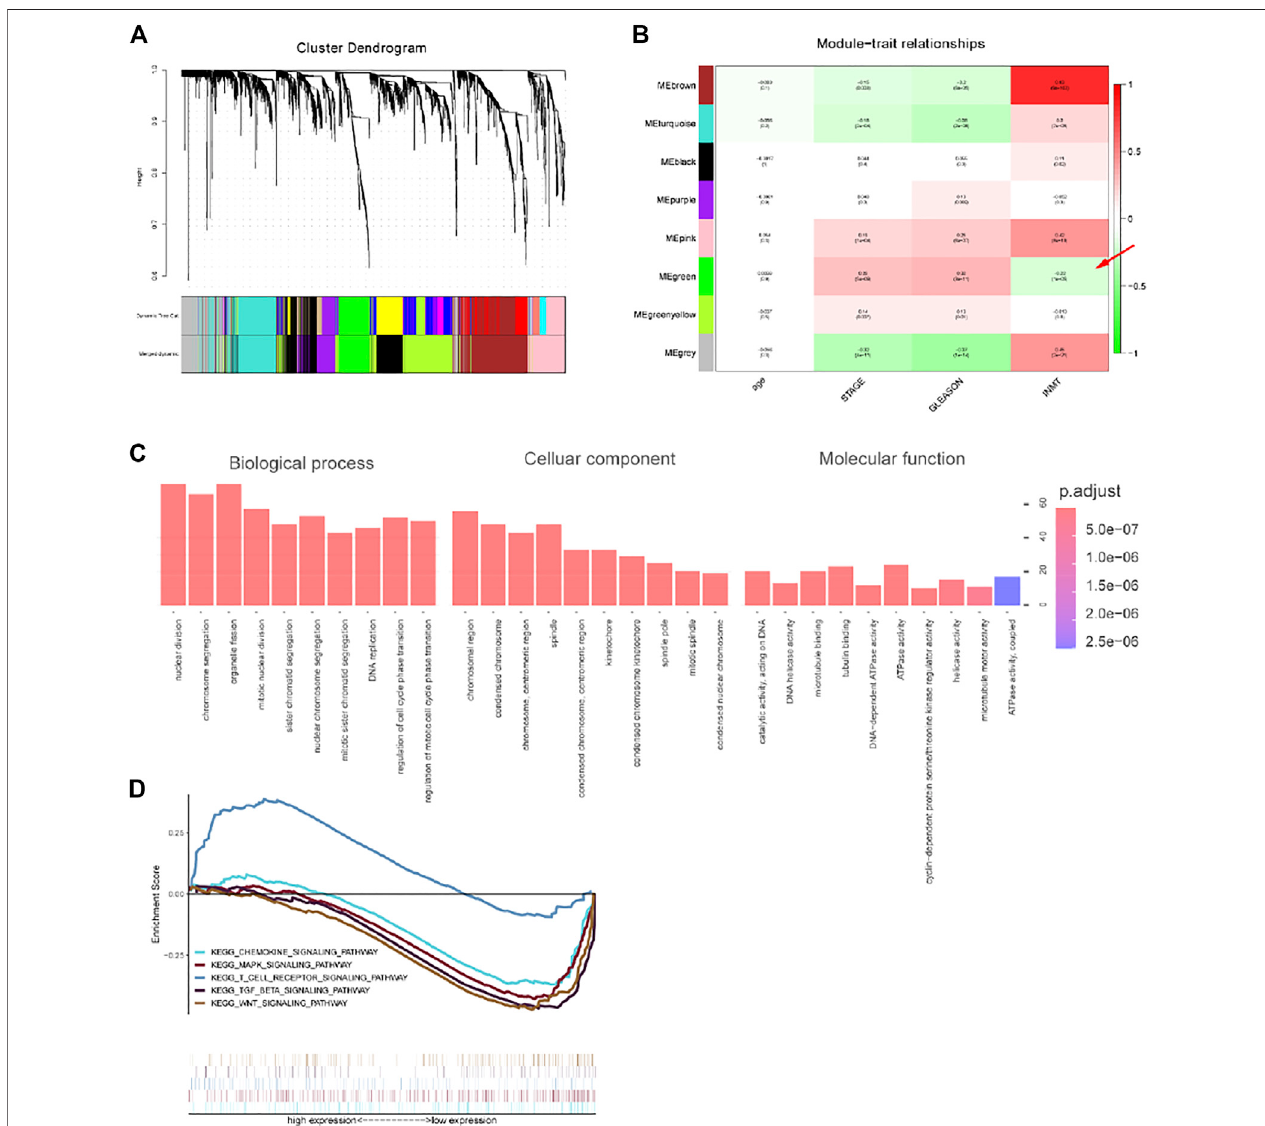
FIGURE3| Resultsofweightedgeneco-expressionnetworkanalysisinTCGA-PRAD. (A) Ahierarchicalclustertreewasconstructed,witheachleafrepresentinga gene and each branch representing a co-expression module. A total of eight co-expression modules were generated. (B) Correlation coef fi cients between different factors and co-expression modules, where the brown (COR = 0.83; p < 0.001), gray (COR = 0.45; p < 0.001),and pink modules (COR = 0.42; p < 0.001) had a positive correlation with INMT, and the green module (COR = -0.22; p < 0.001) had a negative correlation with INMT. (C) The pathway enrichment analysis of the INMT co- expression genes in the green module. (D) The KEGG pathway annotation and enrichment analysis of the INMT co-expression genes in the green module.